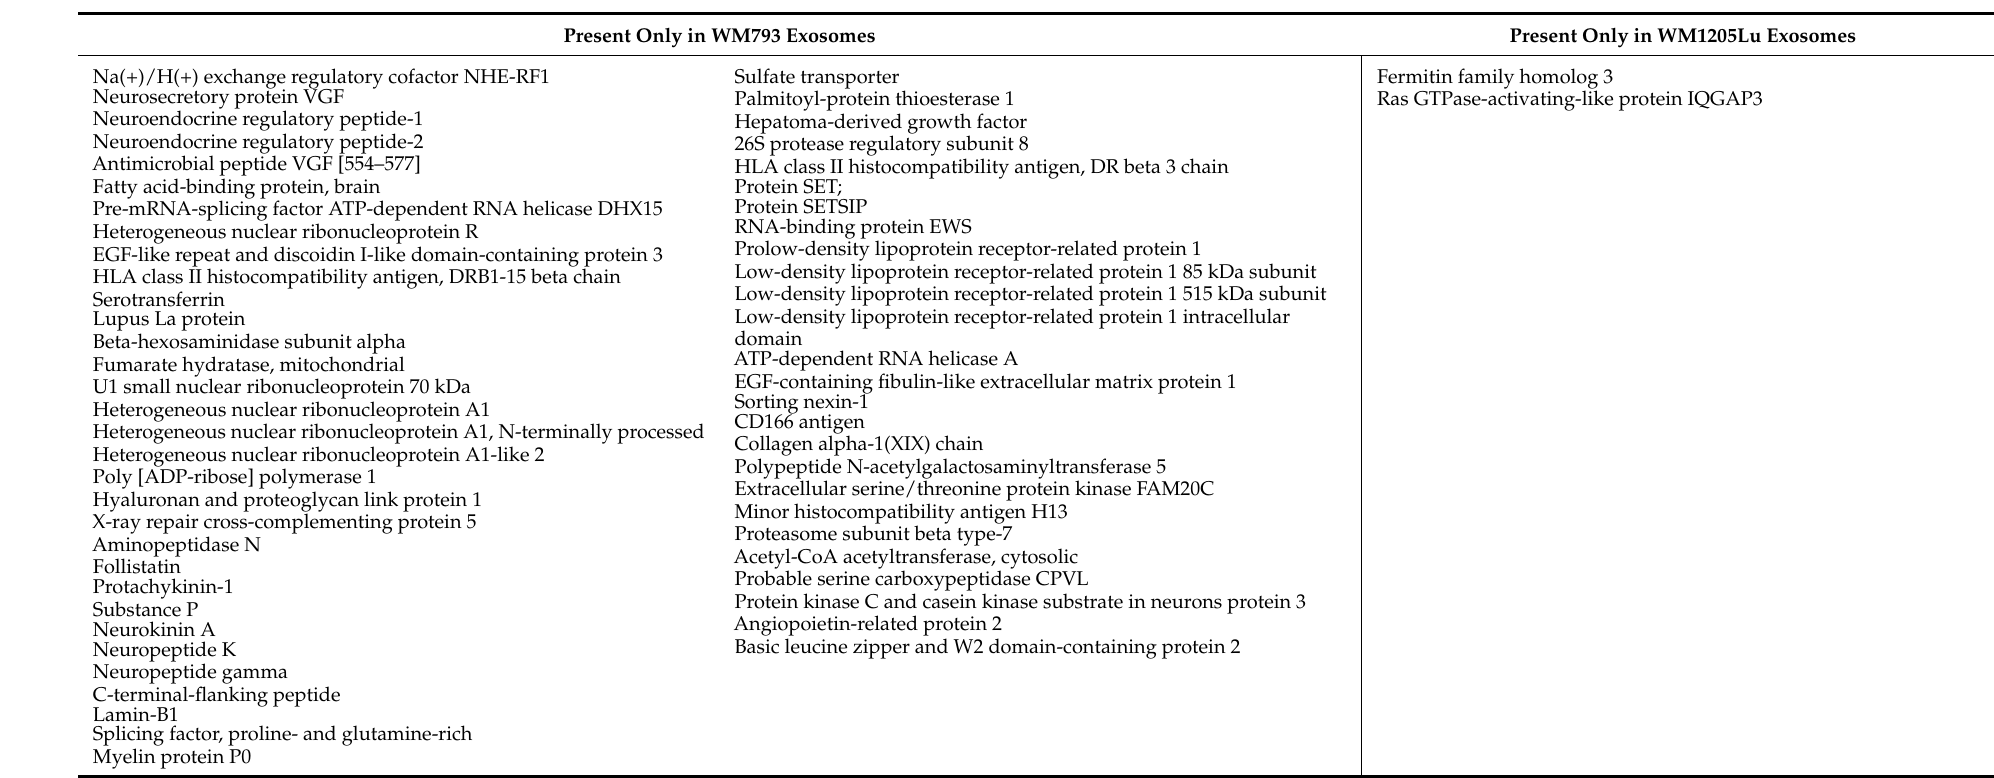
Table 3. List of proteins identified in WM793-derived exosomes but not found in any replicates of WM1205Lu-derived exosomes and vice